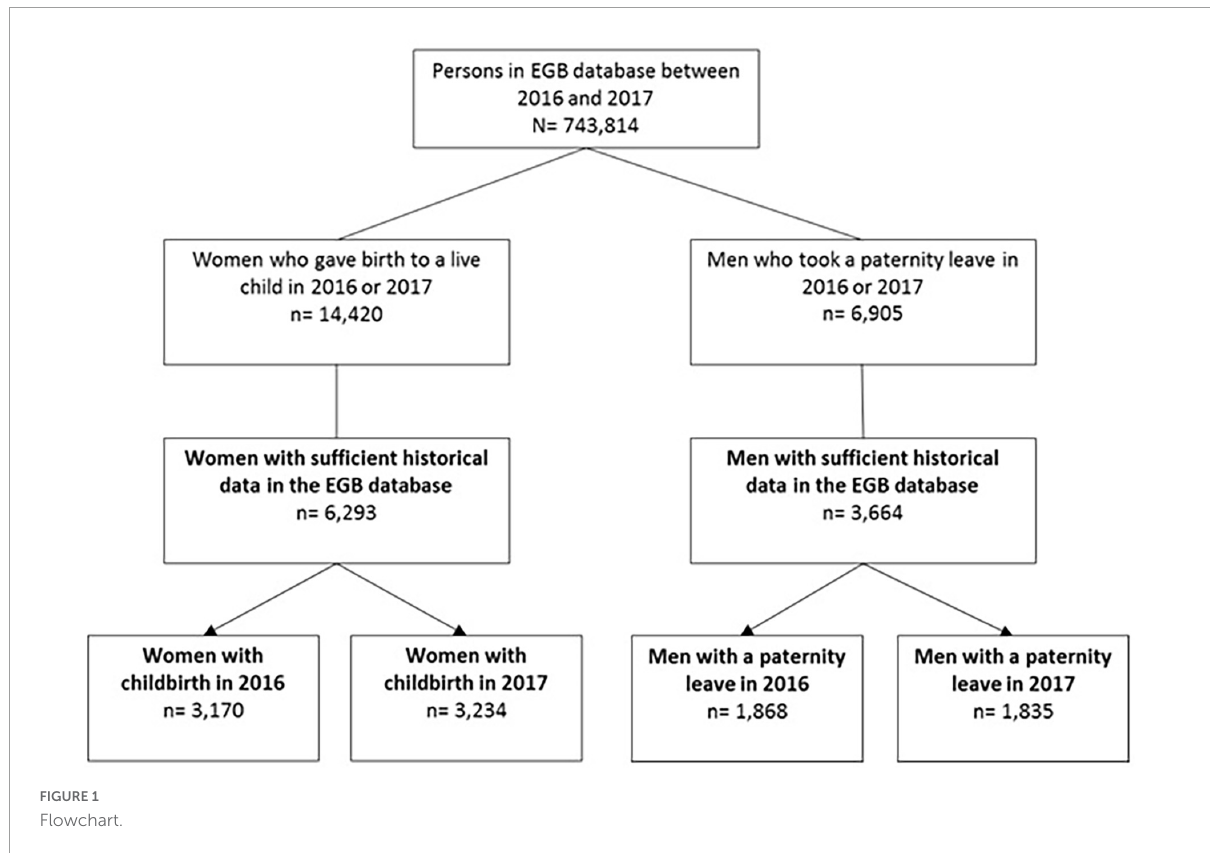
FIGURE1 Flowchart.